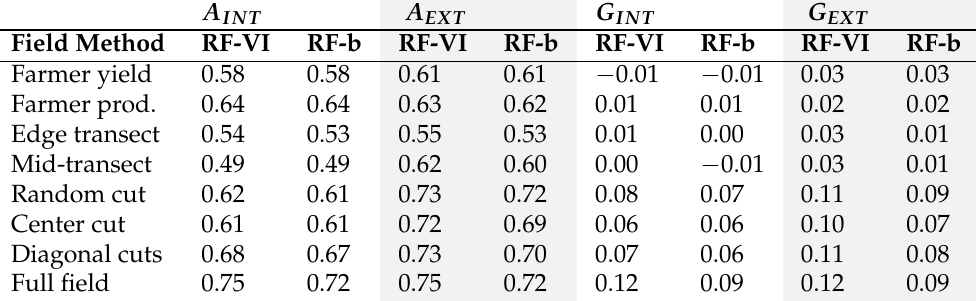
Table A3. Internal ( A INT ) and external accuracy ( A EXT ) and gain ( G INT and G EXT ) for models predicting maize yield from reflectance based on data from different field methods. For each field method, we show the Random Forest (RF) model using the VIs (RF-VI) and the Random Forest model using the raw bands